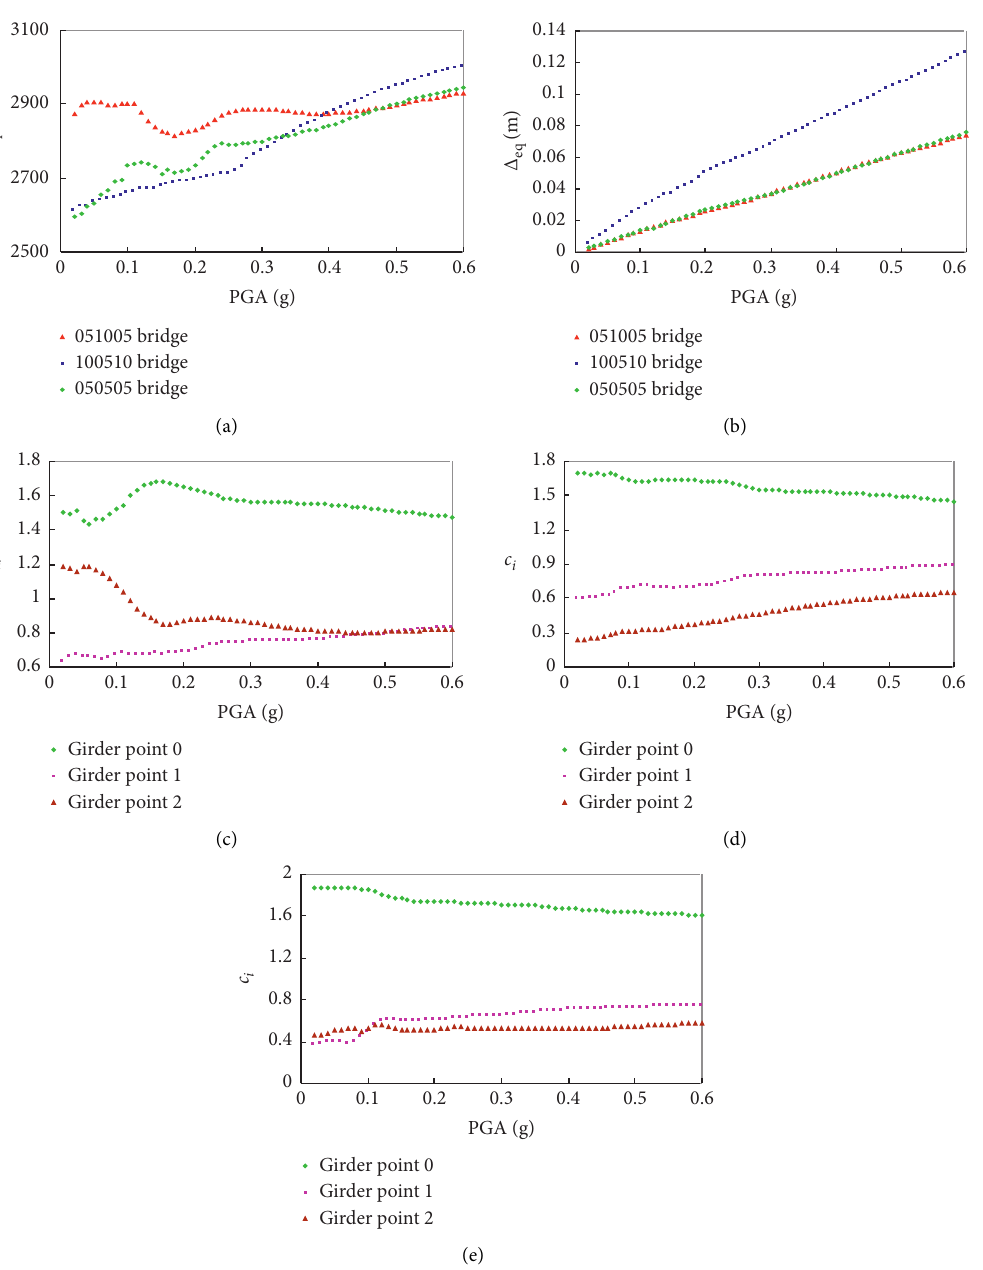
Figure 3: Equivalent SDOF system: (a) mass, (b) displacement, (c) coefficient of displacement shape of the 051005 bridge, (d) coefficient of displacement shape of the 100510 bridge, and (e) coefficient of displacement shape of the 050505